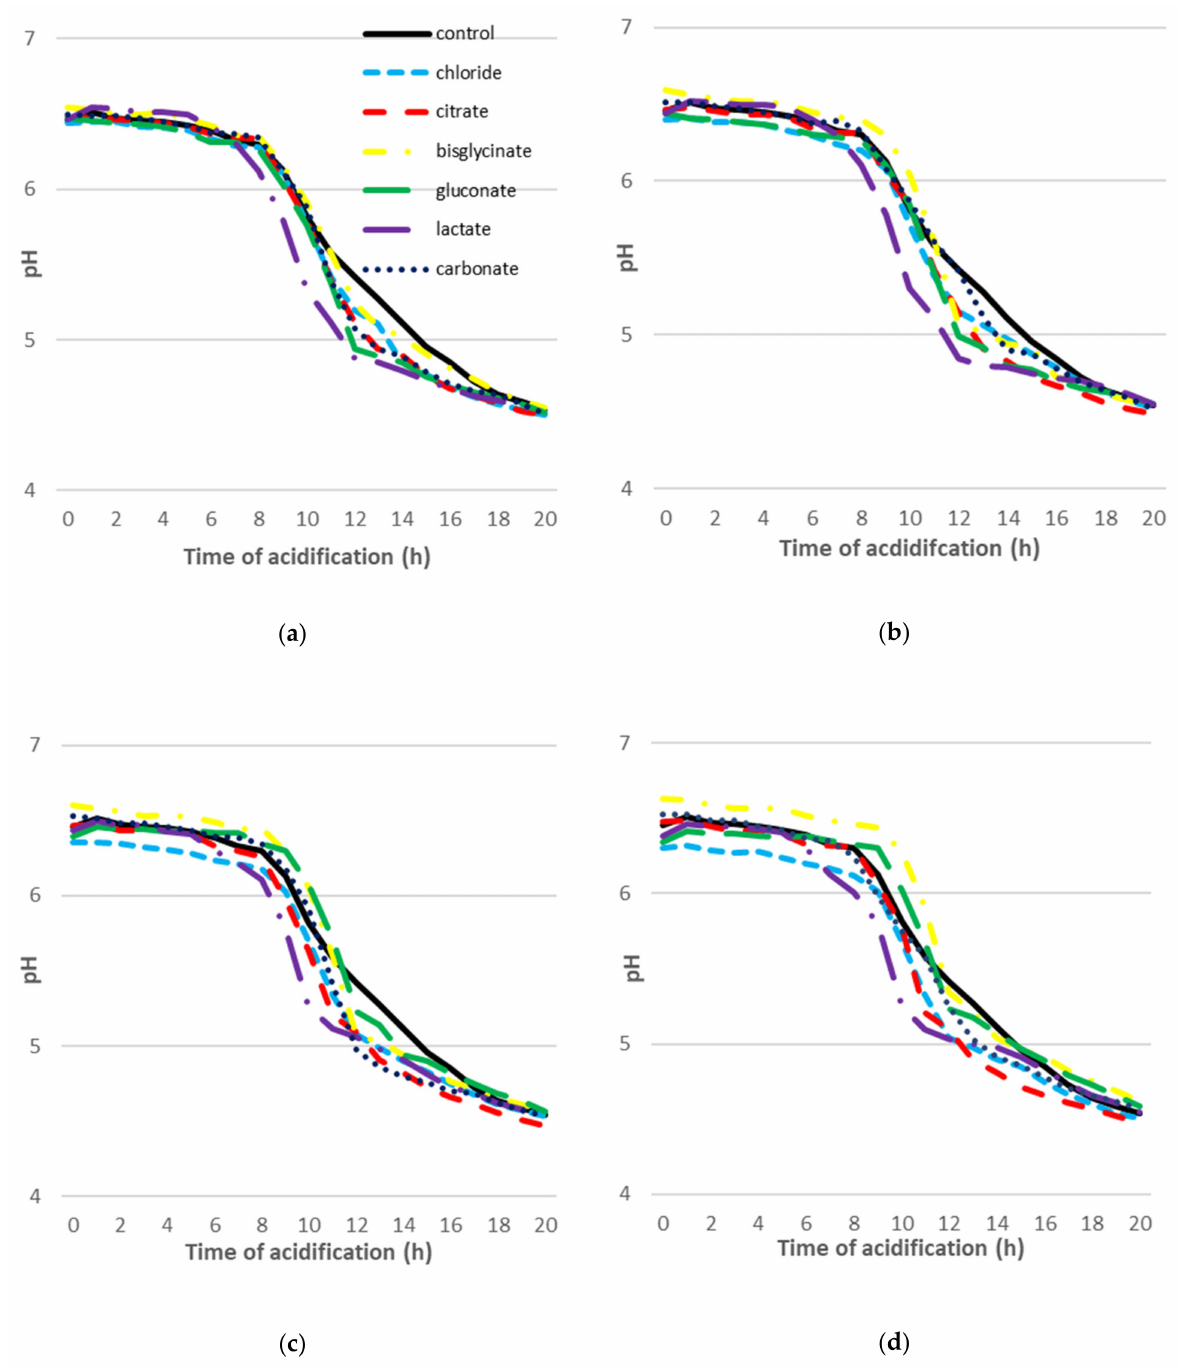
Figure 1. Acidification process of control goat milk samples (without calcium addition) and with addition: 5 mg Ca 100 g − 1 of milk ( a ), 10 mg Ca 100 g − 1 of milk ( b ), 15 mg Ca 100 g − 1 of milk ( c ), 20 mg Ca 100 g − 1 of milk ( d ), in the form of calcium chloride, calcium citrate, calcium bisglycinate, calcium gluconate, calcium lactate, and calcium